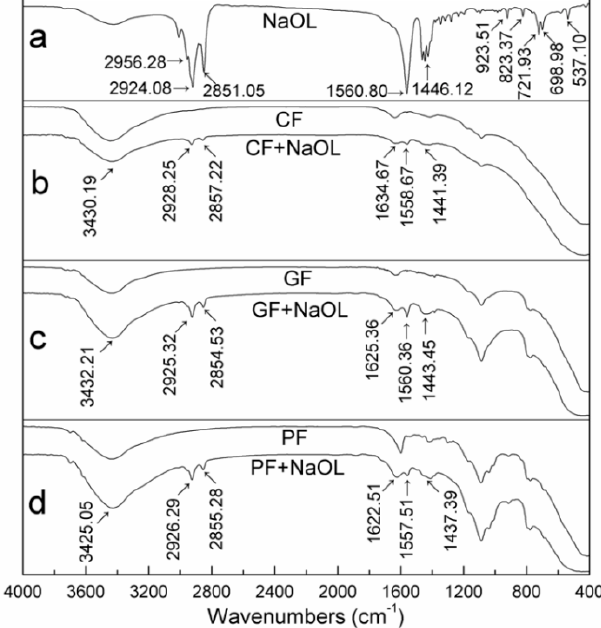
Figure 6. Fourier transform infrared (FT-IR) spectra of different colored fluorites before and after adsorption of NaOL in a neutral solution.